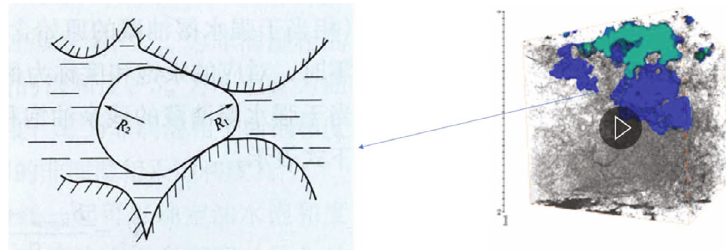
Figure 19: Pore network simulation to analyze the mechanism of gas injection sealability from the pore throat